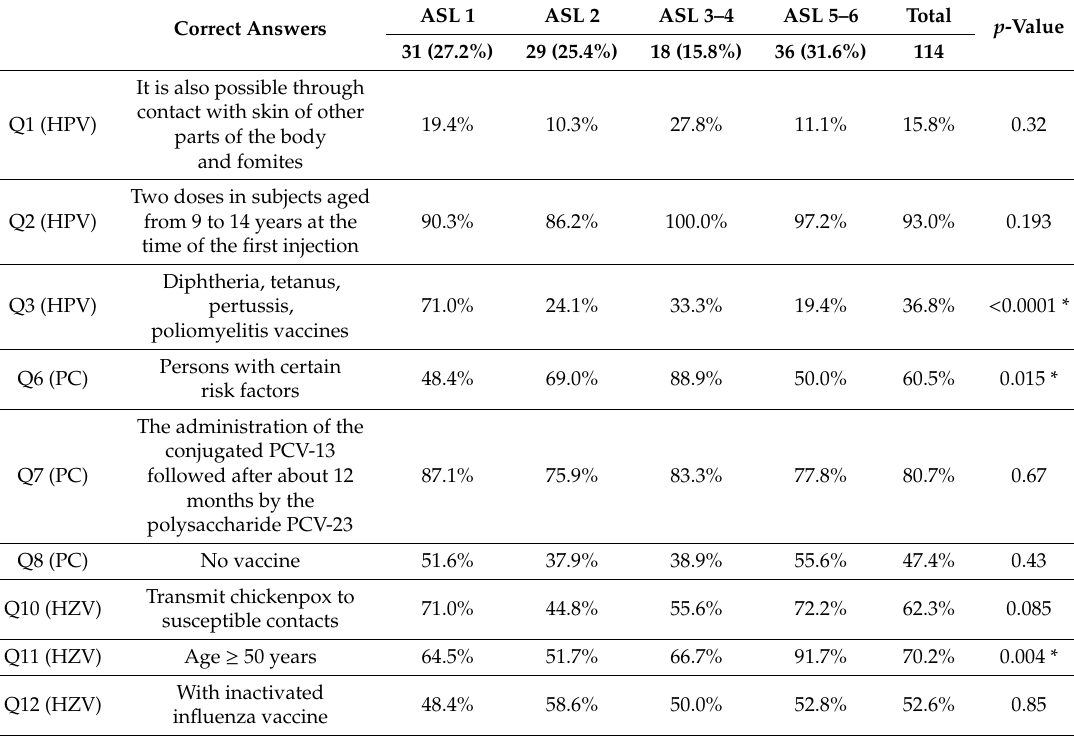
Table 3. Questions with correct